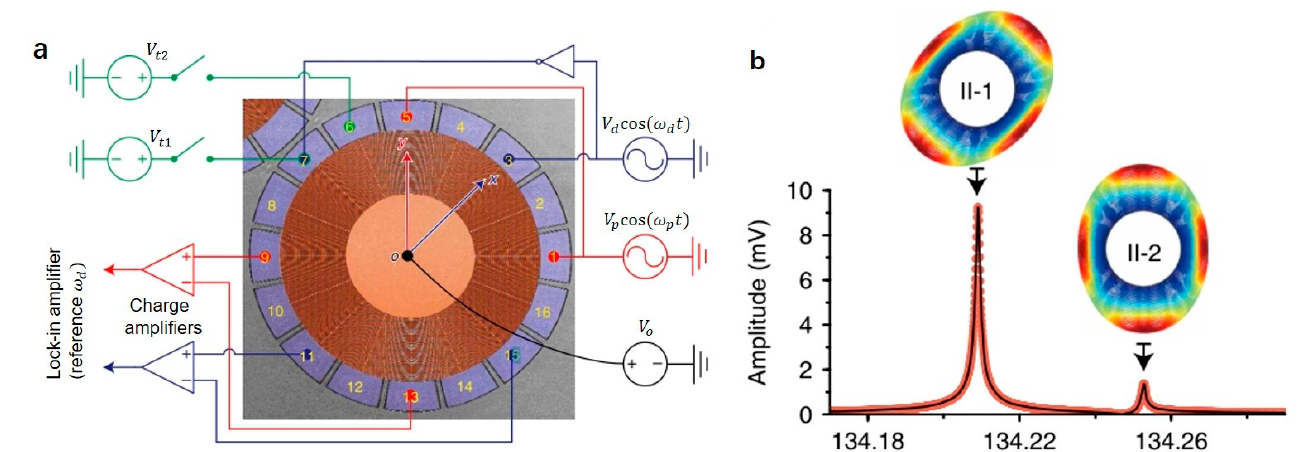
Figure 9. ( a ) The experimental platform of ring resonator gyroscope. Uniformly distributed capacitor electrodes to achieve driving, tuning, and detection. ( b ) Measured mechanical mode of the resonator. Adapted with permission from [27].